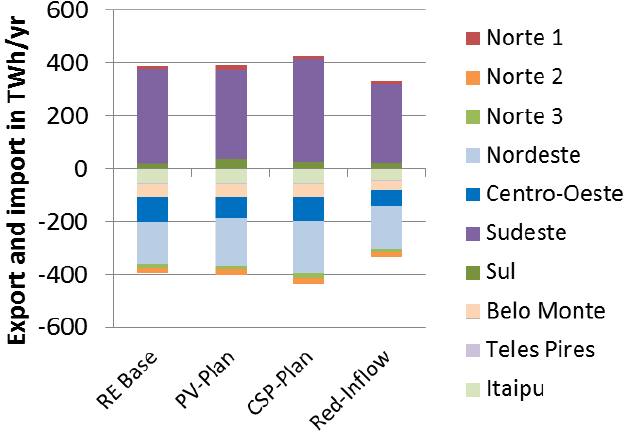
Figure 8. Calculated annual power transmission between the regions; positive values indicate net imports, while negative values net exports in 2050. imports, while negative values net exports in